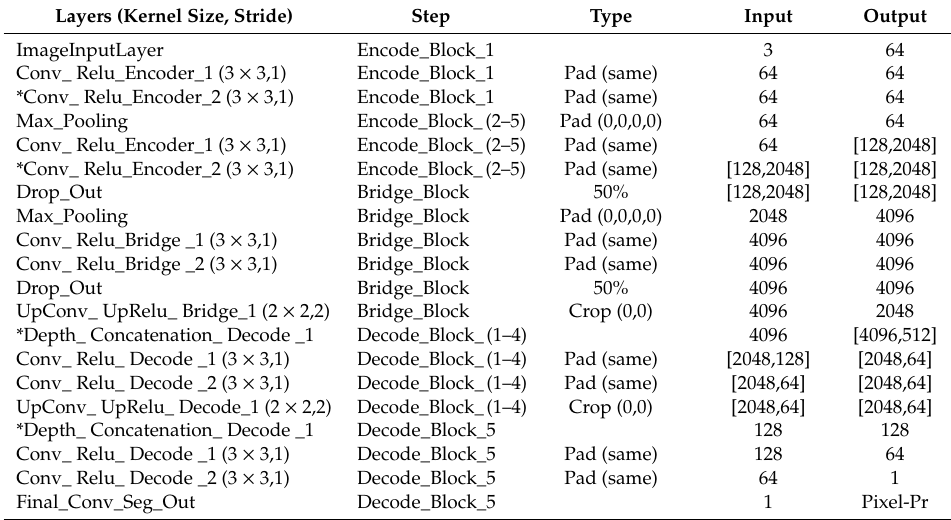
Table 1. General structure HoppingNet. * = information extraction and weight concatenation at this layer. Pixel-Pr = prediction at the pixel level. [128, 2048] = There are many repeated blocks in the encode layer and decode layer. We express the number of convolutional layer channels at the same position in the block by the brackets of the double or half